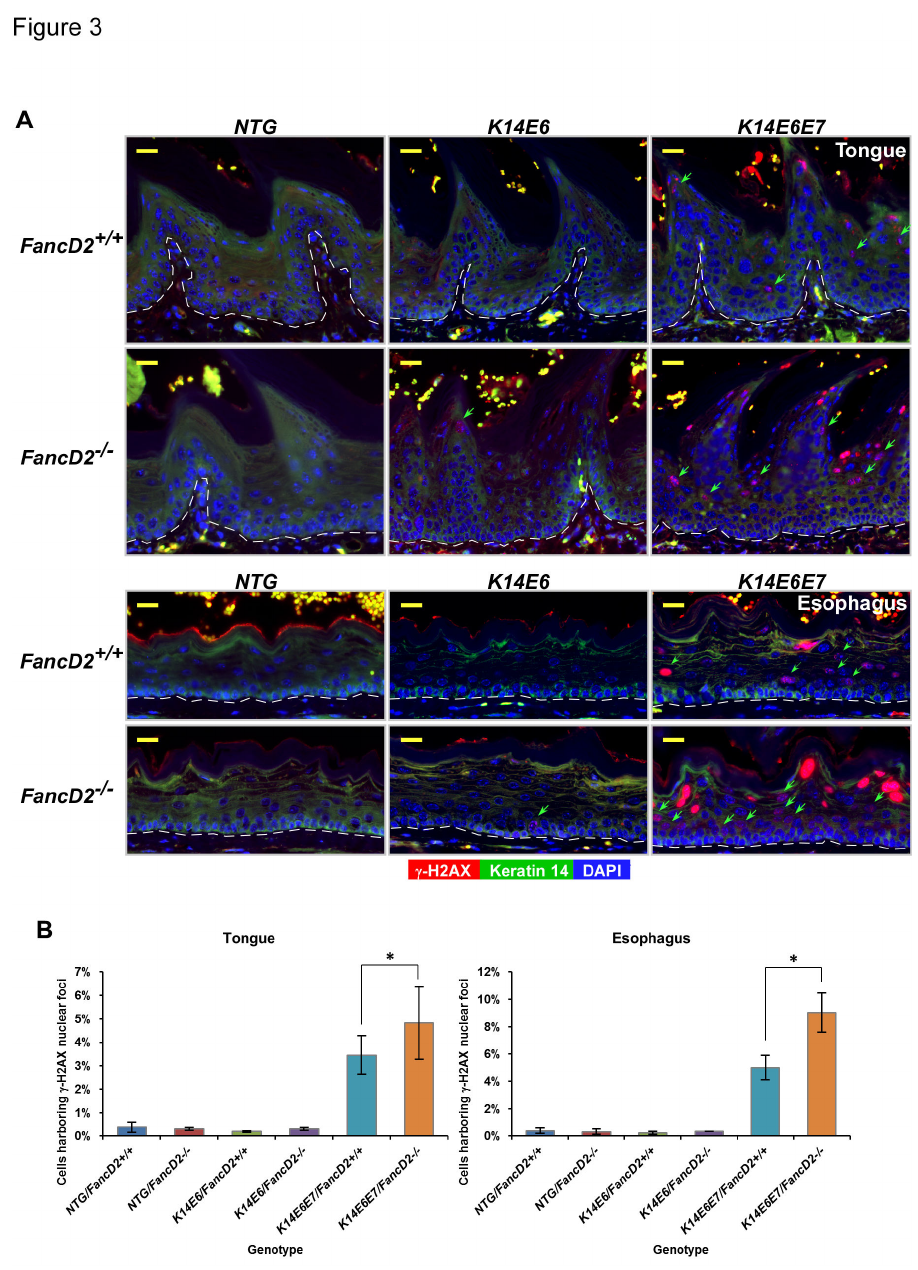
Figure 3. HPV16 E7-dependent DNA damage response via γ-H2AX was accelerated by the deficiency of fancD2 gene. A . To assess induced DNA damage response by HPV16 E6 and E7 in the deficiency of fancD2 gene, tissues from each group were stained for anti-γ-H2AX (red) and anti-cytokeratin 14 (CK14) protein (green) antibodies. DAPI is used for a nuclear counterstaining. Scale bar, 20µm. γ-H2AX foci positive cells are highlighted by green arrows in the images. B . At least three mice of each genotype, NTG/FancD2 +/+ , NTG/FancD2 -/- , K14E6/FancD2 +/+ , K14E6/FancD2 -/- , K14E6E7/FancD2 +/+ , and K14E6E7/FancD2 -/- mice, were selected and ~8 to 10 frames of cells at the epithelial layers of the tongue and esophagus were quantified for each mouse. The amount of cells with γ-H2AX positive foci cells over the number of total cells was plotted in each case (columns); bars, SD. Asterisk (*) means that the differences in the number of cells with γ-H2AX foci between the groups were statistically compared ( P <0.05). All statistical comparisons were performed using a two-sided Wilcoxon rank-sum test. Note: Exposure times used were the same for all samples analyzed. Some cells in tissues of K14E6E7/FancD2 +/+ and K14E6E7/FancD2 -/- mice had very bright γ-H2AX-specific nuclear staining at the exposure used. Shorter exposure confirmed that these cells retained punctuate nuclear staining reflective of DNA damage response foci. doi: 10.1371/journal.pone.0075056.g003 PLOS ONE |